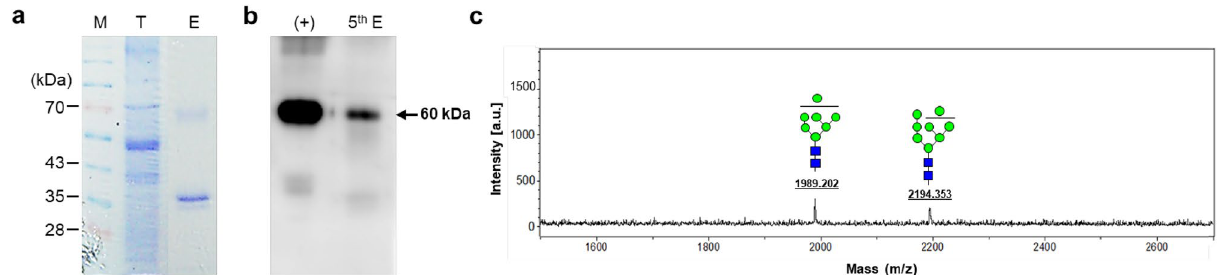
Figure 3. The rGA733-Fc protein purification and glycosylation pattern analysis. rGA733-Fc protein was purified from the transgenic tomato plants using a protein A column. ( a ) The eluted fractions were separated by SDS-PAGE and visualized by Coomassie brilliant blue staining. M, protein size marker; T, total soluble protein; E, purified rGA733-Fc protein. ( b ) rGA733-Fc protein in 5th eluted fraction was detected with the rGA733-2 antibody by western blot analysis. 5th E, 5th eluted fraction. ( c ) Glycosylation patterns of purified rGA733-Fc protein were analyzed by Matrix-assisted laser desorption/ionization time-of-flight (MALDI-TOF) mass spectrometry (MS). Blue square, N -acetylglucosamine (GlcNAc); green circle,